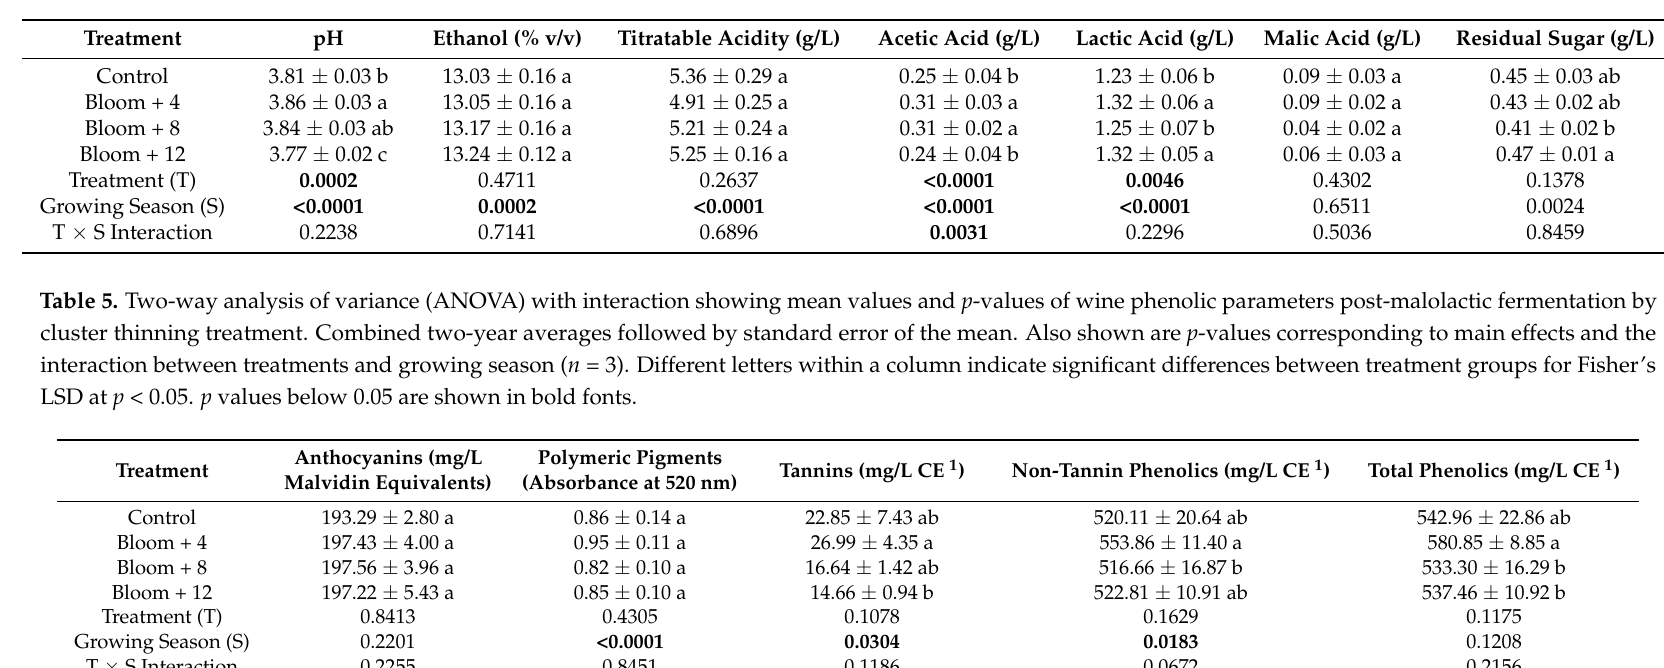
Table 4. Two-way analysis of variance (ANOVA) with interaction showing mean values and p -values of wine composition parameters post-malolactic fermentation by cluster thinning treatment. Combined two-year averages followed by standard error of the mean. Also shown are p -values corresponding to main effects and the interaction between treatments and growing season ( n = 3). Different letters within a column indicate significant differences between treatment groups for Fisher’s LSD at p < 0.05. p values below 0.05 are shown in bold fonts.